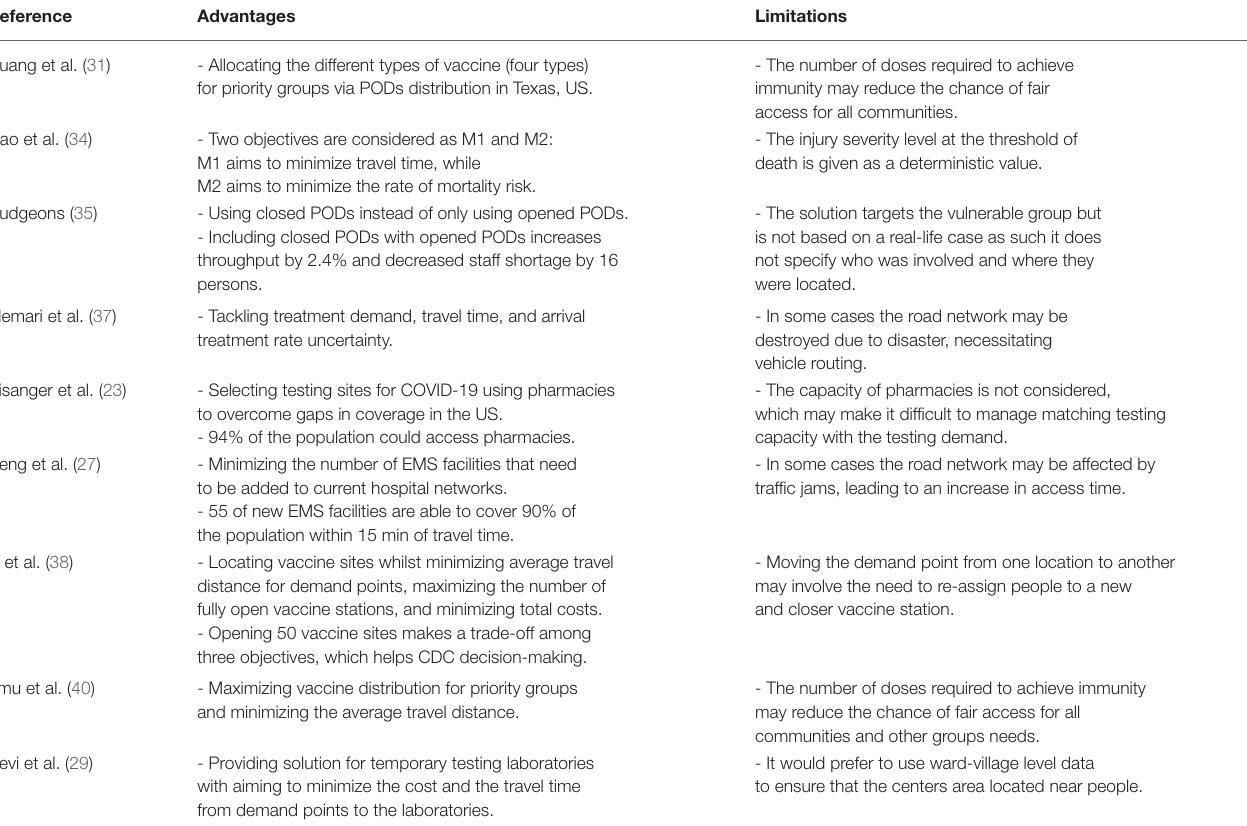
TABLE 6 | A comparison of location-allocation solutions for PODs during public health emergencies based on their advantages and limitations. Reference